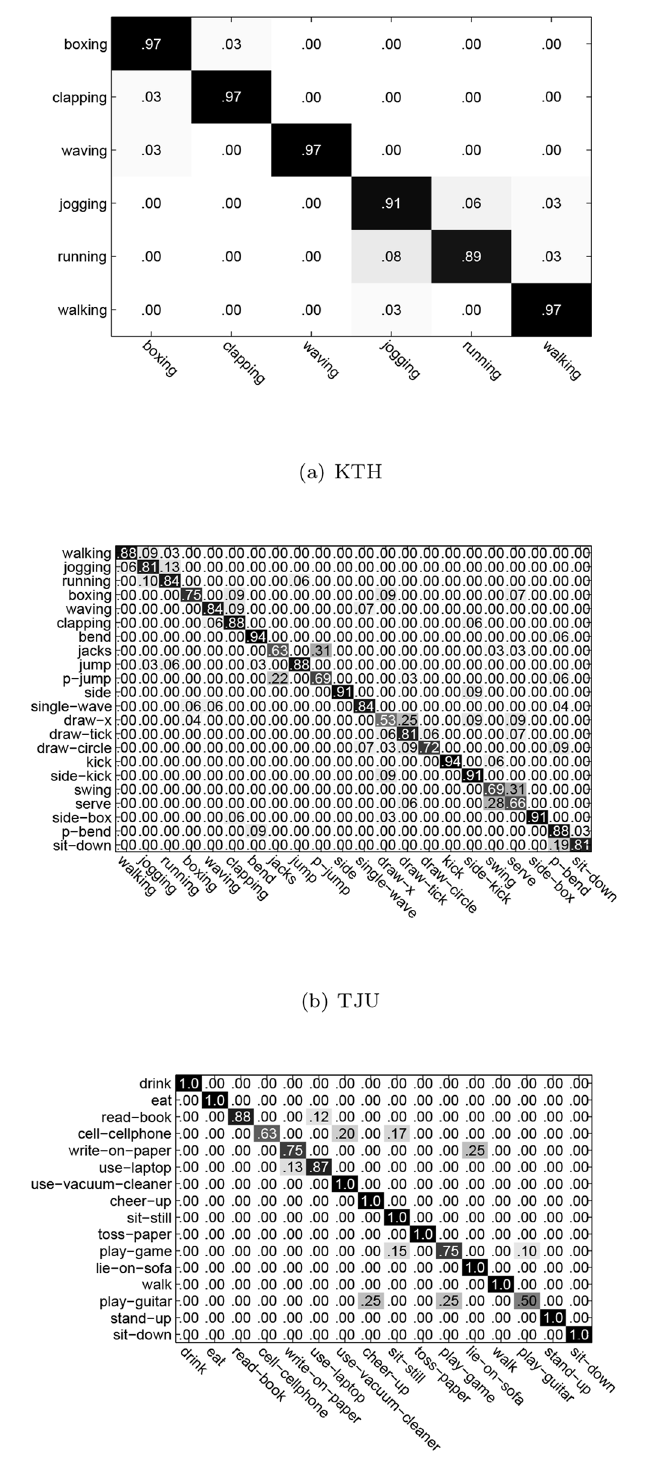
Fig 7. The confusion matrixes of All-MTCRFs on KTH, TJU, and MDA.